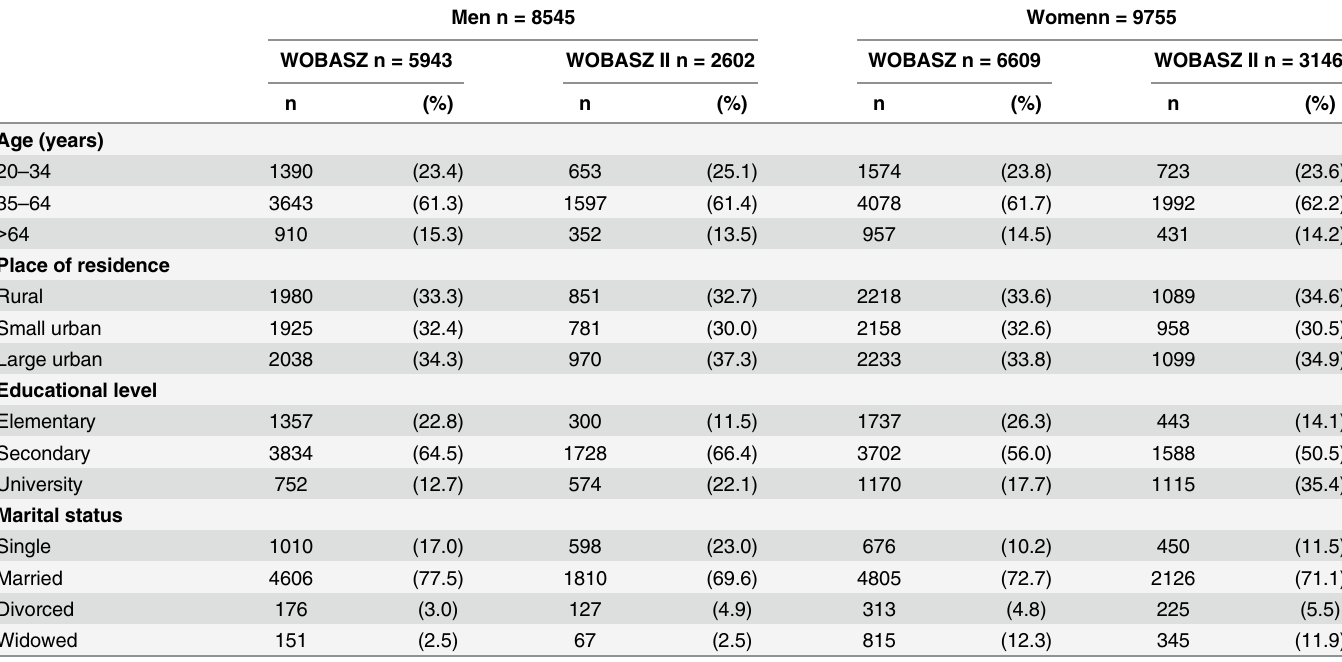
Table 1. Sociodemographic characteristics of the studied population in the WOBASZ (2003 – 2005) and WOBASZ II (2013 – 2014)